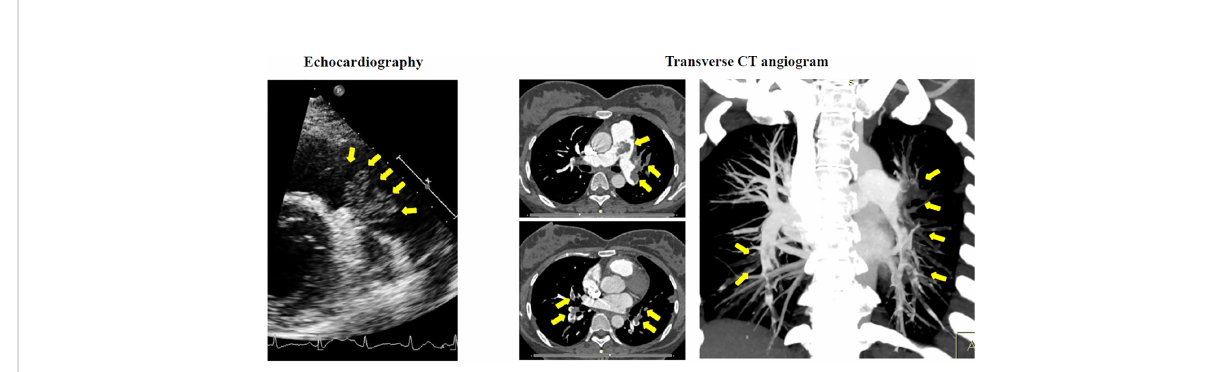
FIGURE 1 Preoperative echocardiography demonstrated a large lobulated mass (arrows) attached by a pedicle to the posterior wall of pulmonary truck. Transverse CT angiogram revealed a diffused occlusion of both pulmonary arteries